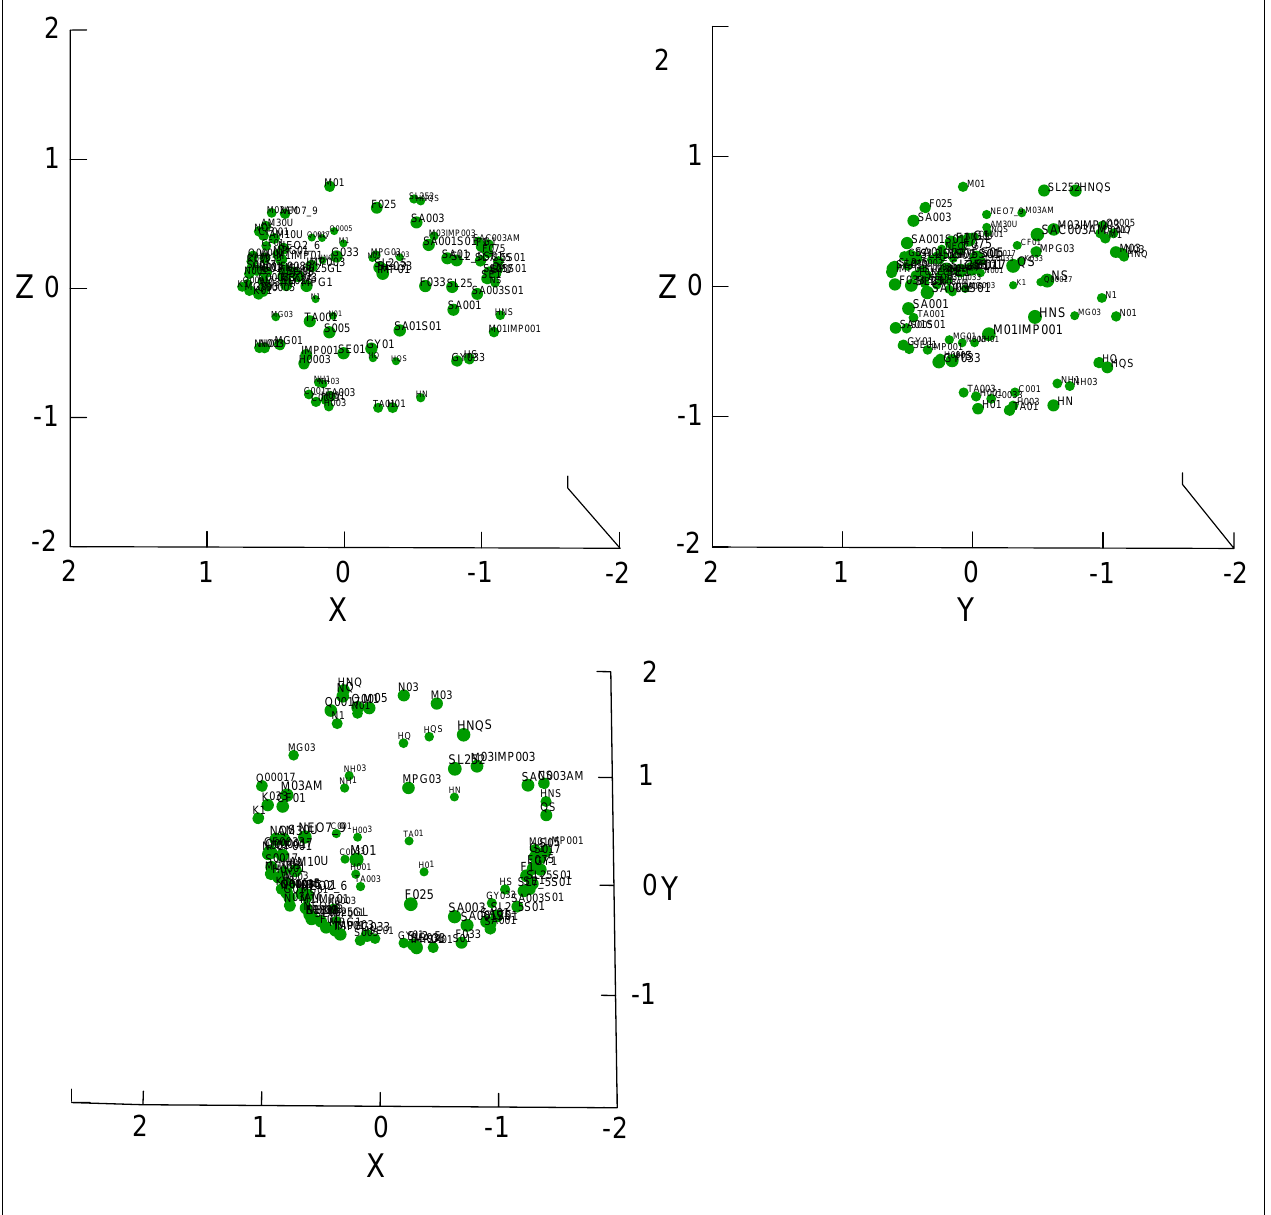
FIGURE 9 | 3D MDS taste space of all stimuli. Three projections of the 100-stimulus taste space are provided, showing that it is shaped like a sphere, not a tetrahedron. See alsoVideo S2 in Supplementary Material for a rotating version of this MDS.